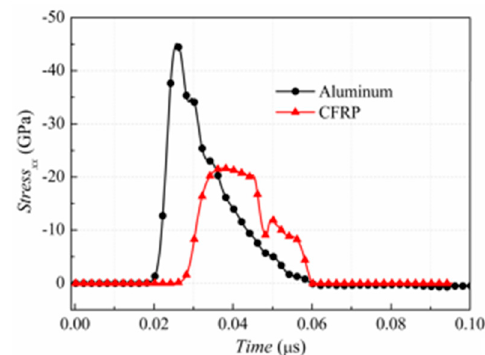
Figure 5. Stress history of CFRP and aluminium panels.